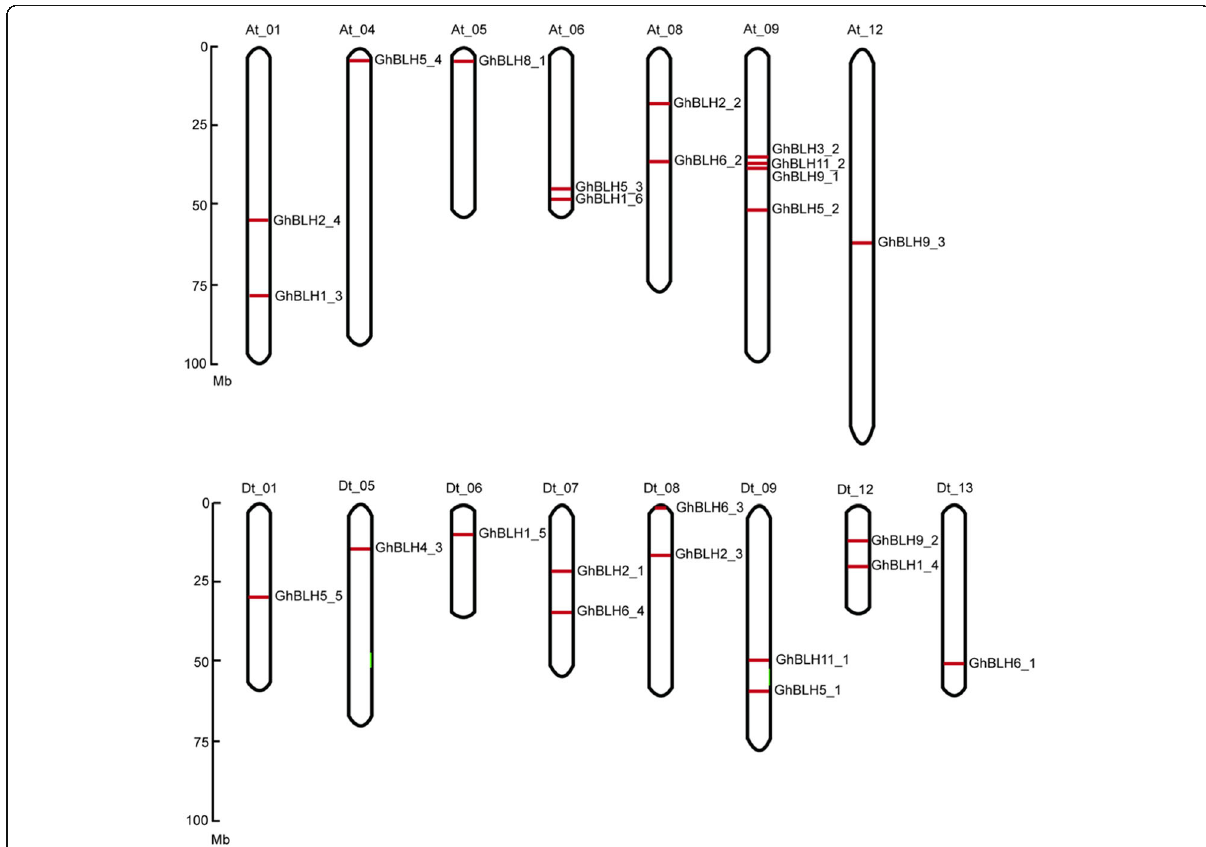
Fig. 2 Distribution of BLH genes on G. hirsutum . The scale represents megabases (Mb). The chromosome numbers are indicated above each vertical